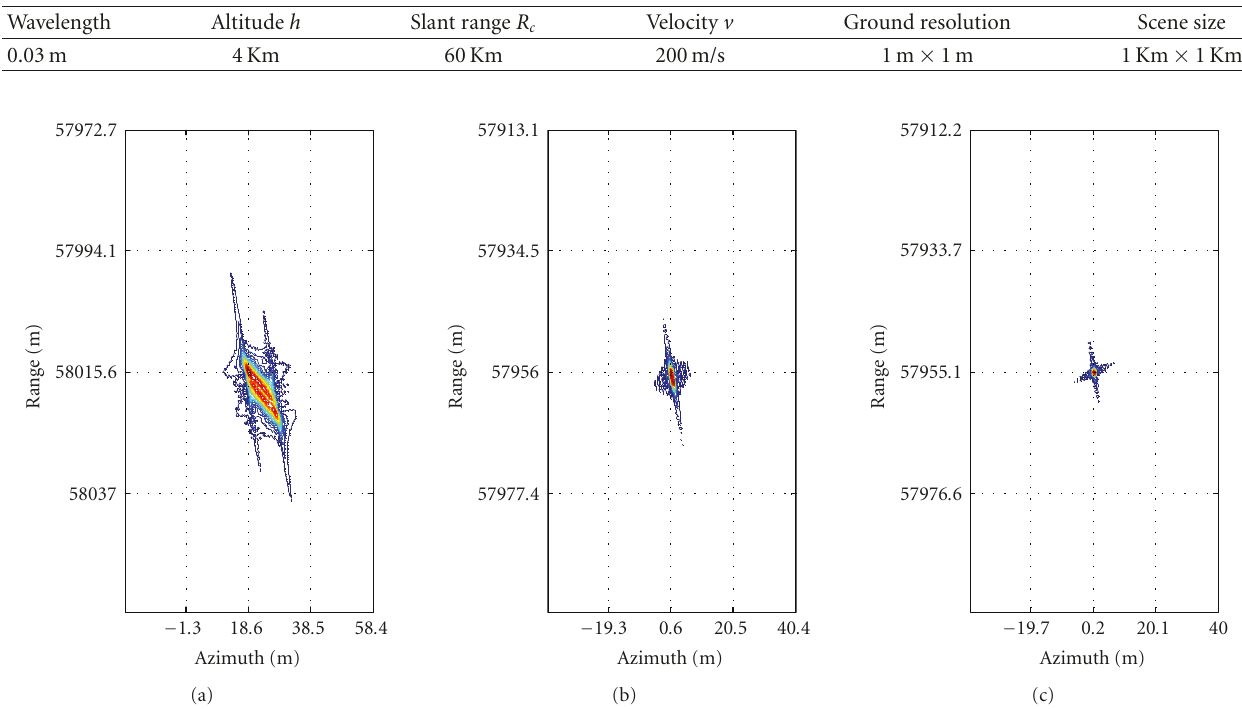
Table 1: System parameters for an airborne X-band SAR.